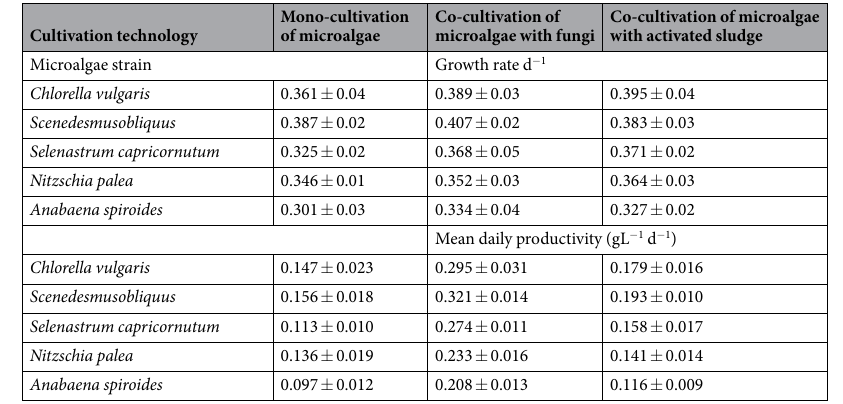
Table 1. Growth rates and mean daily productivity of five microalgae strains under different microalgae cultivation